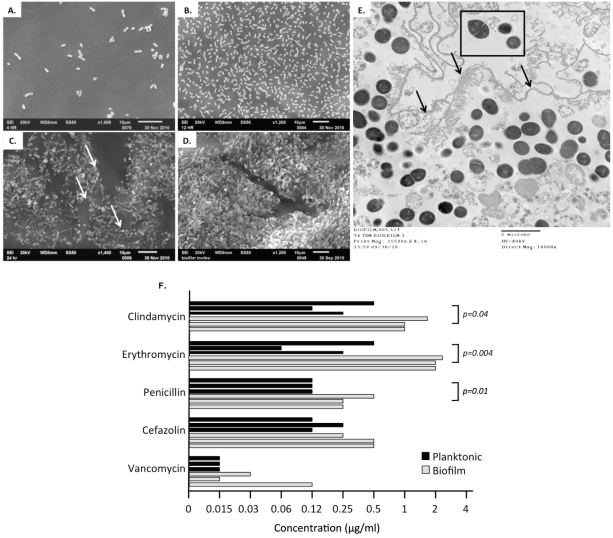
Visual characterization of S. pneumoniae mature biofilm development in vitro.Scanning electron microscipy images representative (n = 6) of mature S. pneumoniae (TIGR4) biofilms developed in vitro under once through conditions. Images of biofilm growth at 4 h (A), 12 h (B), 24 h (C) and 48 h (D) are depicted. Transmission electron microscopy image of a cross section of a mature pneumococcal biofilm grown for 48 h is shown (E). Note the demarcation of the outer matrix edge (black arrows), the presence of viable and dead pneumococci enveloped within the matrix, and the presence of surface exposed diplococci available for dispersal (within black box). (F) Tolerance to the killing effect of the designated antimicrobials was determined by measuring the concentration for which >103 CFU were viable after 5 h's of incubation with the antibiotic. Wells were inoculated with 105 CFU/ml. Results from three independent experiments are shown. Statistical analysis was performed using a two-tailed Student's t-test.